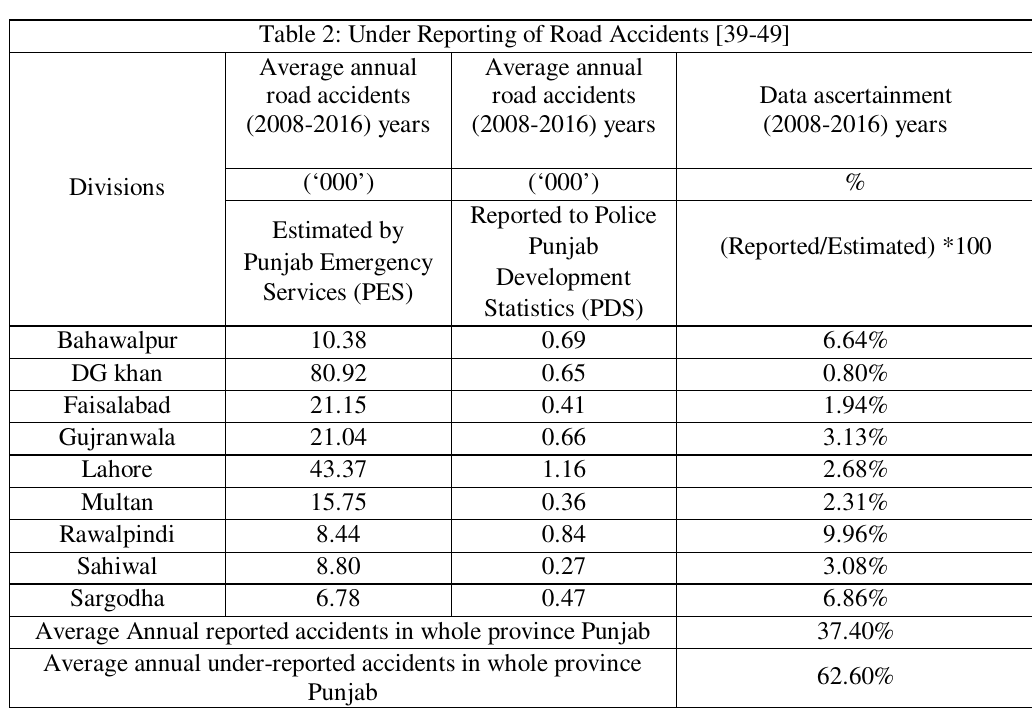
Table 2: Under Reporting of Road Accidents [39-49]